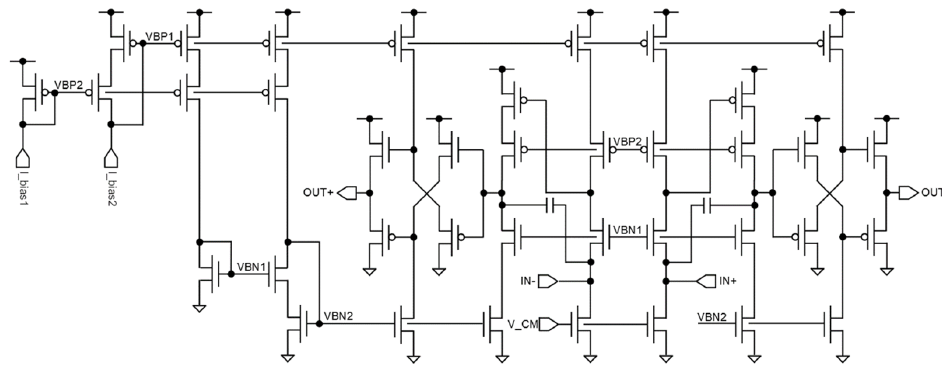
Figure 8. A simplified schematic diagram of the transimpedance amplifier.